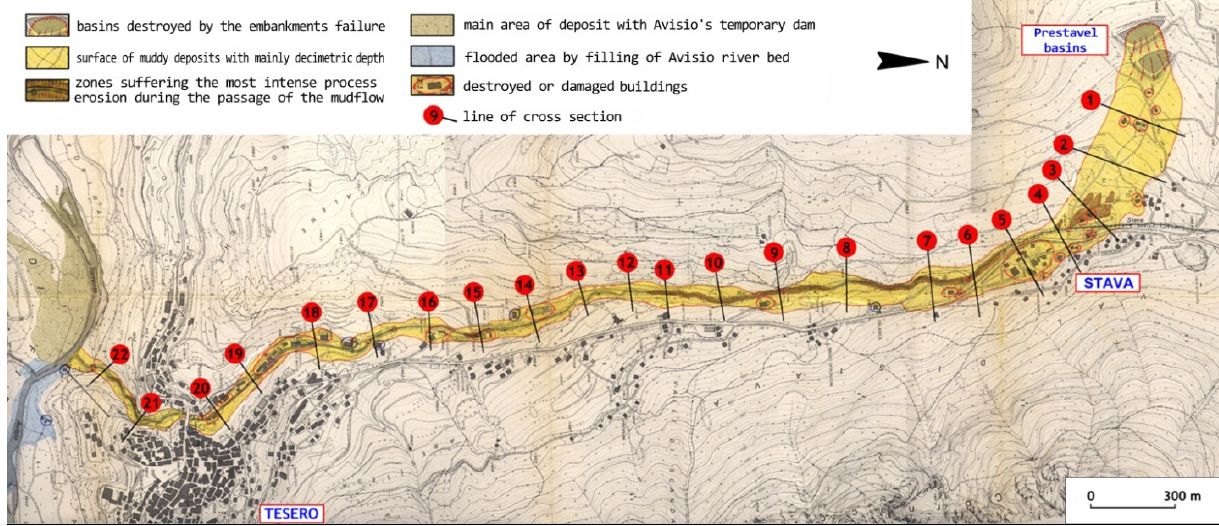
Fig. 11 ‐ Mudflow path of July 19, 1985 along the Stave Valley showing different effects observed by the geologists of CNR ‐ IRPI, Torino during the first surveys. The locations of twenty ‐ two cross ‐ sections measured during the survey are highlighted. The original map base is 1:5.000 scale (from Govi and Luino, 2003, modified).